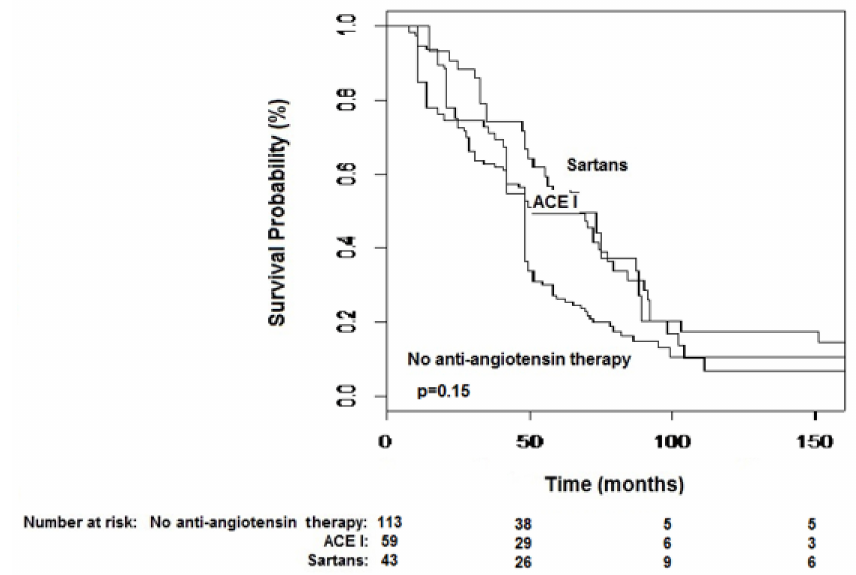
Figure 1. Kaplan–Meier curves of overall survival stratified by anti-hypertensive therapy. Median